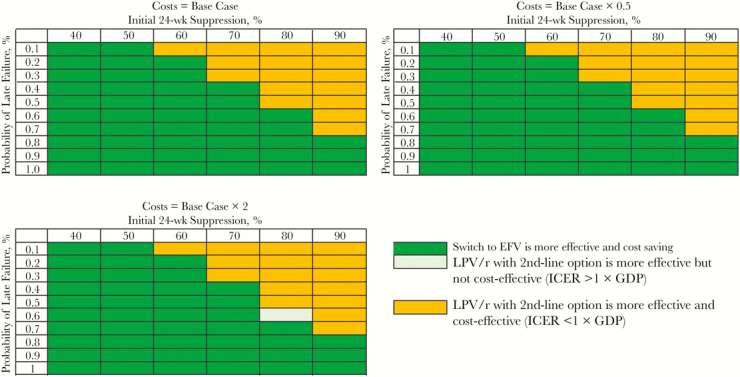
Multivariate sensitivity analyses of the impact of simultaneous variation in characteristics of the antiretroviral therapy (ART) regimen after failed ritonavir-boosted lopinavir (LPV/r) in the LPV/r with second-option strategy, including initial suppression, monthly risk of late failure, and costs. In each panel, the monthly risk of late failure of the ART regimen that would follow LPV/r failure in the LPV/r with second-line option strategy is shown on the vertical axis, and the initial 24-week suppression with that regimen is shown on the horizontal axis. The top left panel shows base case ART costs for this regimen. The top right panel shows results when the cost of this regimen is reduced by half. The bottom panel shows results when the cost is doubled. Green shading indicates scenarios in which the switch strategy is cost saving (leading to greater life expectancy and lower lifetime costs), compared with LPV/r with second-line option; pale green shading indicates that the LPV/r with second-line option strategy projects the longest life expectancy but is not cost-effective, and the switch strategy is economically preferred. Orange shading indicates scenarios wherein LPV/r with second-line option is cost-effective compared with the switch strategy. Costs and life-years are discounted at 3% per year. Abbreviations: EFV, efavirenz; GDP, gross domestic product; ICER, incremental cost-effectiveness ratio.